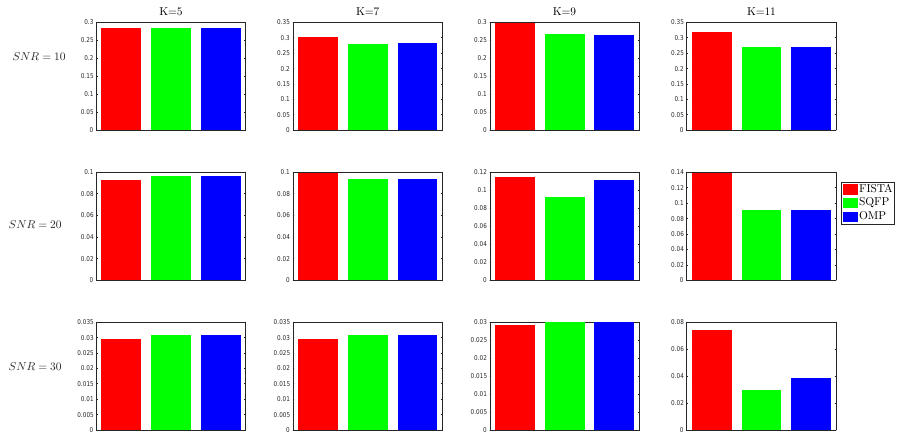
Figure 4. Mean errors for all algorithms, dictionary size 80 × 200, condition number 100.